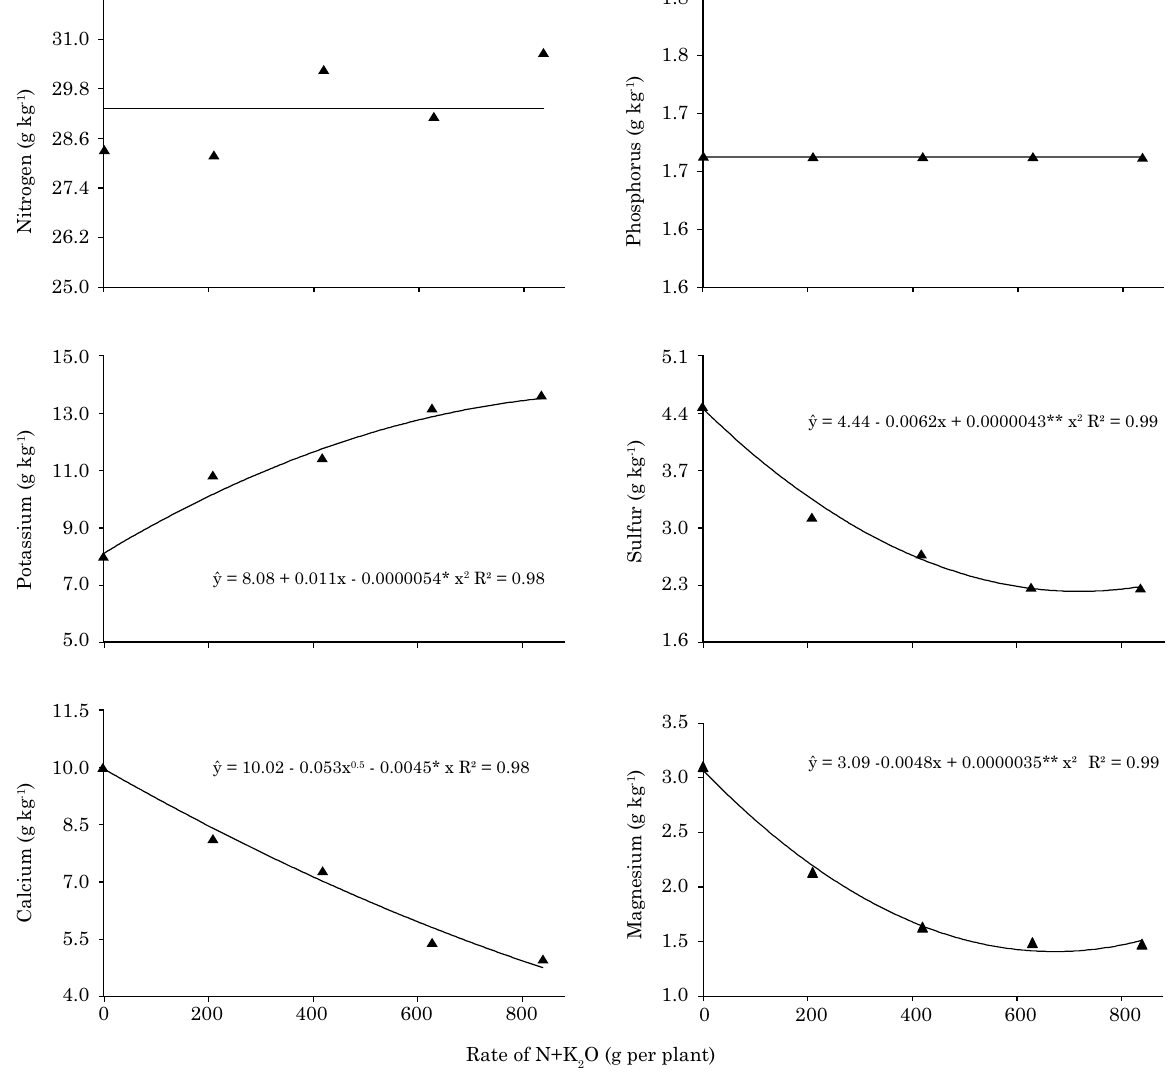
Figure 3. Variation in mineral nutrients contents of macaw plants grown in the field for two years, in response to five side-dressed N and K rates. For N, P, and Ca, effect of rate was not significant by the t test, at 5 %; for K, S and Mg, ** and * indicate significance of the regression coefficient at 1 and 5 % by the t test,